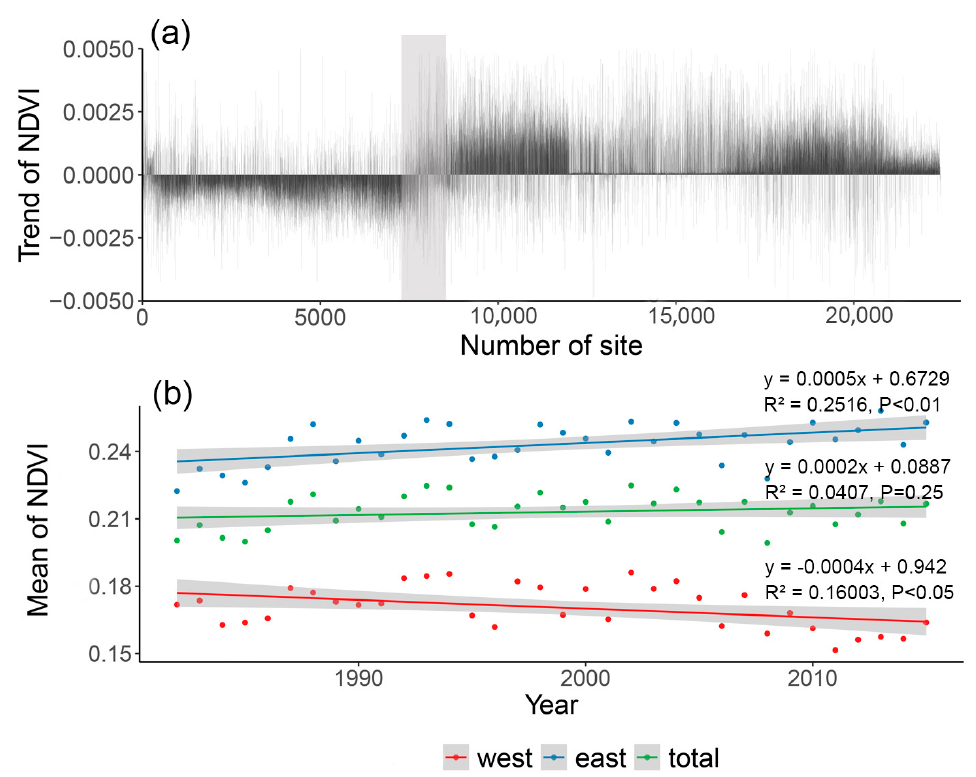
Figure 3. ( a ): NDVI trends during the growing season at different elevations. The X-axis represents all grid points in ACA arranged by elevation instead of the actual elevation as multiple grid points share one elevation; the gray shaded band represents the area where elevation is around 300 m; ( b ): changes in the mean values of growing season NDVI. Green represents the whole region of ACA; red represents the western region of ACA (elevation lower than 300 m), and blue represents the eastern region of ACA (elevation higher than 300 m).